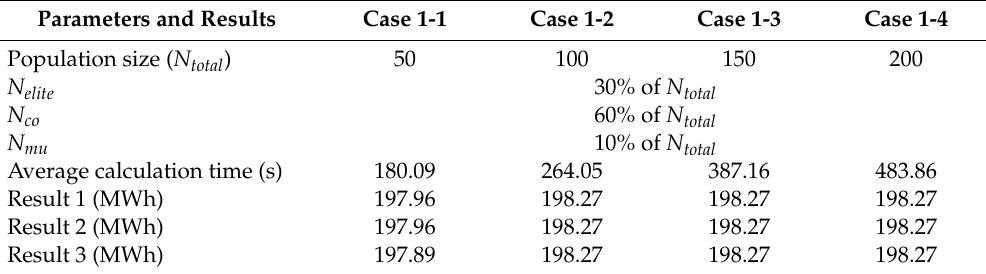
Table 4. Convergence and computation time according to population size.